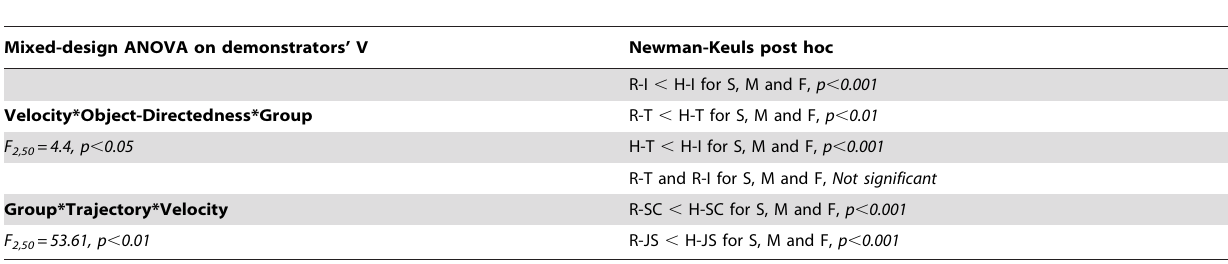
Table 2. Results of the statistical analyses comparing human and robotic demonstrators’ movement velocities.